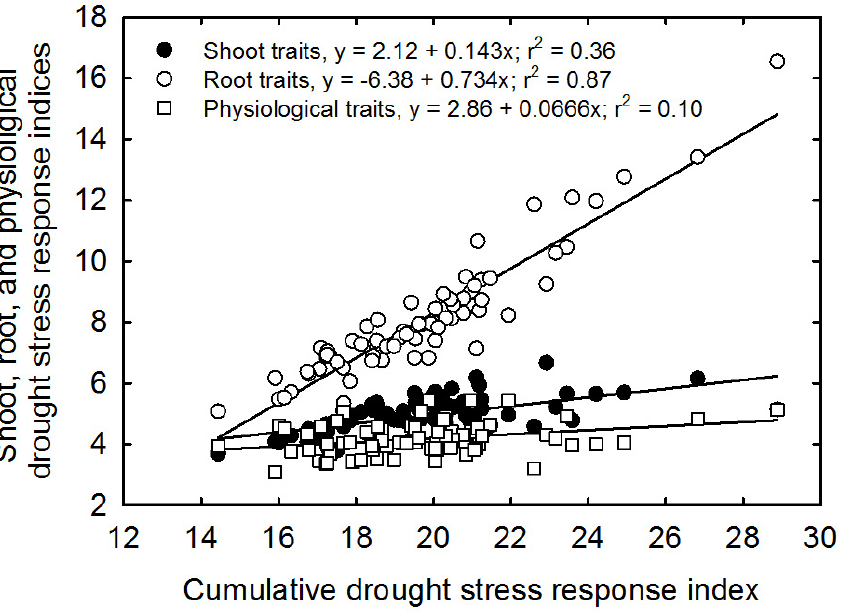
Figure 5. Relationship of the cumulative drought stress response index with the cumulative shoot, cumulative root, and cumulative physiological stress response indices for all 74 rice genotypes. Measurements were taken before harvest (37 DAS) for the shoot and physiological traits and after harvest for root traits.